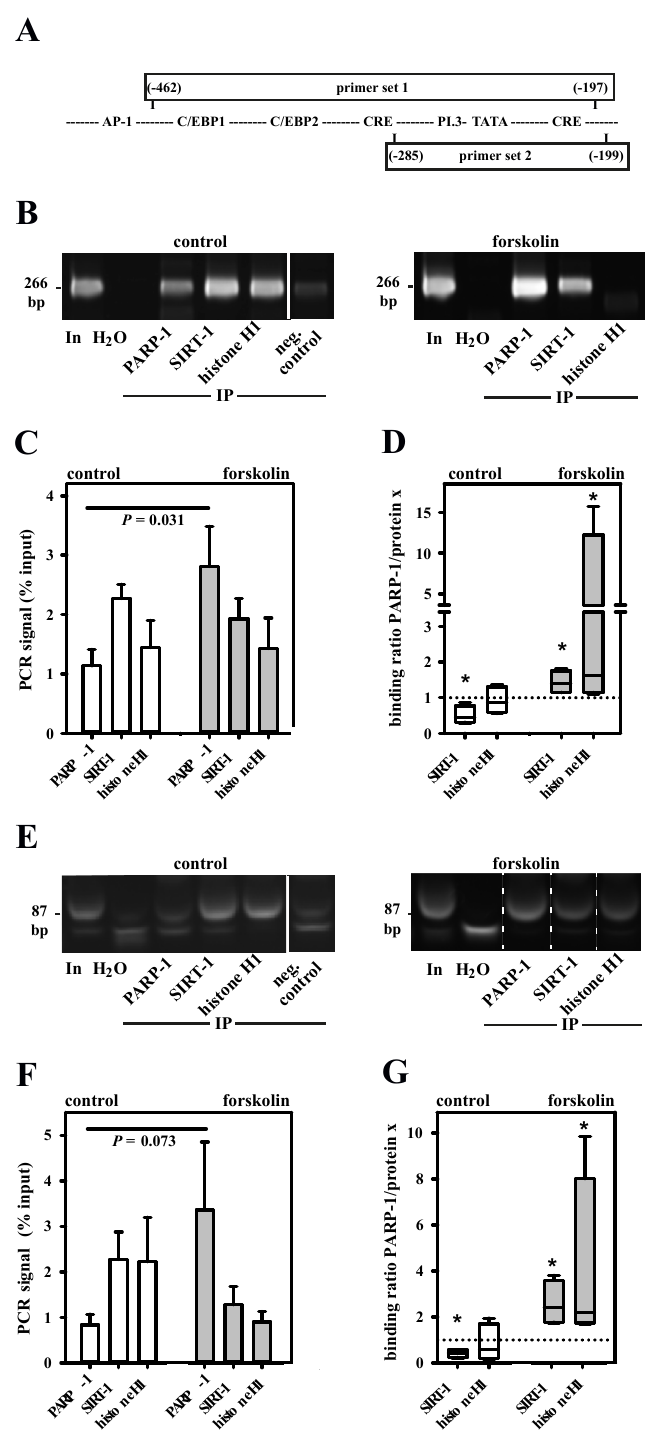
Figure 6. Dynamic interaction of PARP-1, SIRT-1 and histone H1 in the aromatase promoter I.3 / II-region. ( A ) PARP-1, histone H1 and SIRT-1 in vivo binding to the aromatase promoter I.3 / II-region in +/ − forskolin-stimulated BAFs was analyzed by ChIP with two primer sets. The PCR products were separated on 12% polyacrylamide gels and stained with ethidiumbromide. In, input (1:50 diluted non-immunoprecipitated DNA); IP, immunoprecipitated samples; neg. control (protein G without antibodies). ChIP primer sets 1 (( B – D ), 266 bp amplicon) and 2 (( E – G ), 87 bp amplicon) revealed similar results (note that the forskolin-group image in E was cut and pasted to show the bands for PARP-1 and SIRT-1 in the general order of this figure; the original sample order is shown in Figure S2; the smaller band is unspecific). Forskolin stimulation increased PARP-1 binding and increased ratios of PARP-1 / SIRT-1 and of PARP-1 / histone H1 ( n = 4; * p < 0.05 versus control).